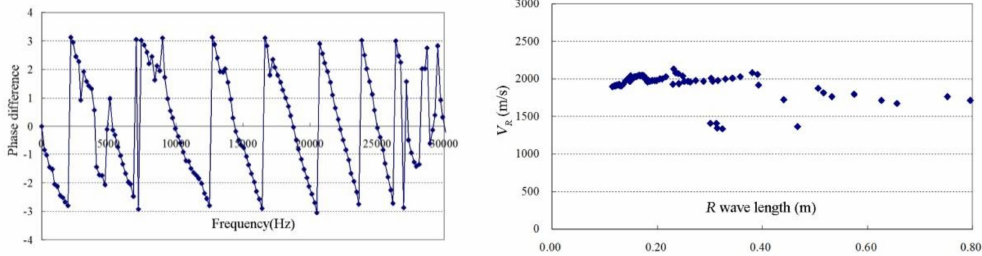
Figure 13. Phase spectrum and dispersion curve of the layered model 3 @ impact duration 500 us.